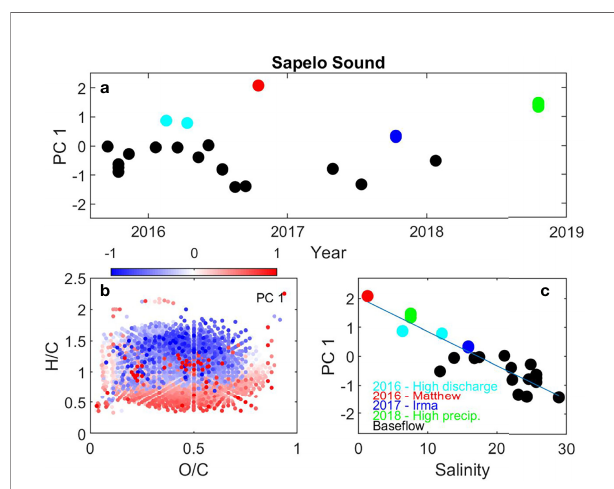
FIGURE 6 | Principal component analysis of DOM composition at the head of Sapelo Sound. (A) Scores of the fi rst principal component. (B) van Krevelen diagram color coded with loadings of PC 1 (colorbar shown on top of panel B ). (C) Scores of PC 1 plotted against salinity. Blue line is a linear fi t to the